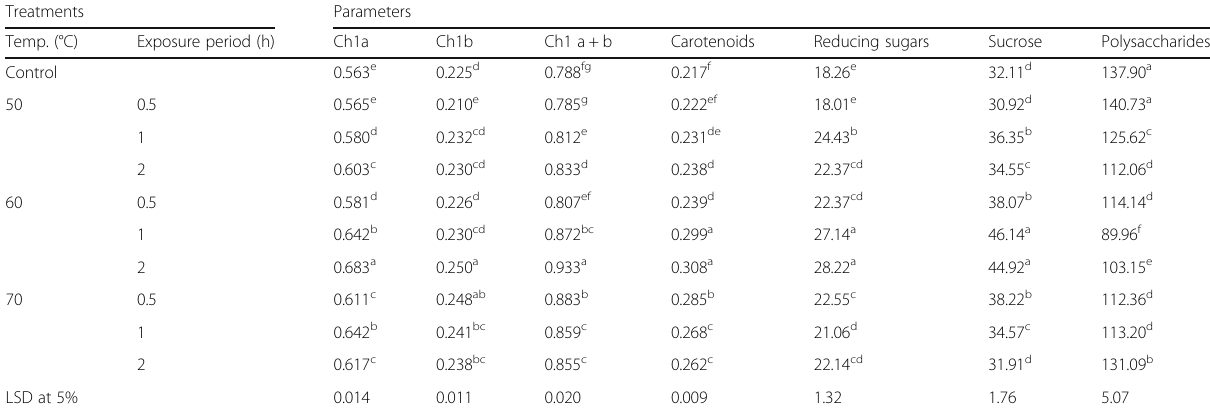
Table 5 Effect of seed hardening on photosynthetic pigments (mg/gm fresh weight of leaves) and carbohydrate content of shoots (mg/glucose/g dry wt.) Treatments